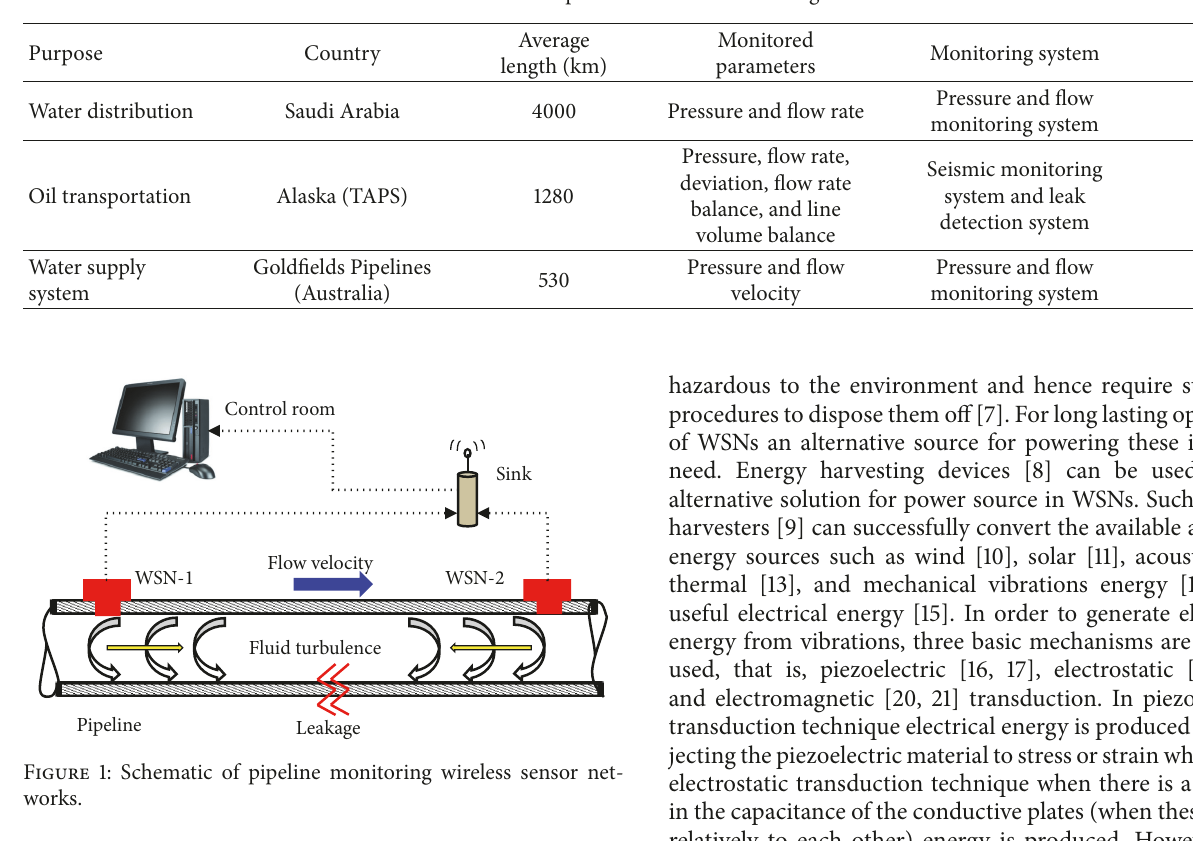
Table 1: Pipeline condition monitoring.